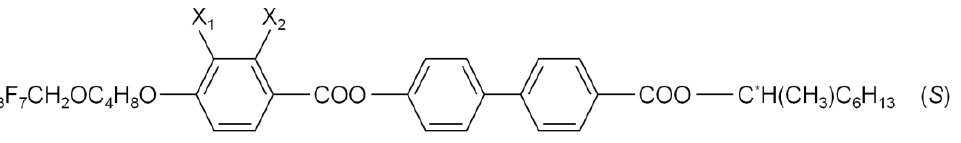
Figure 1. Molecular formula of 4HH (X 1 , X 2 = H, H) and 4FF (X 1 , X 2 = F, F)